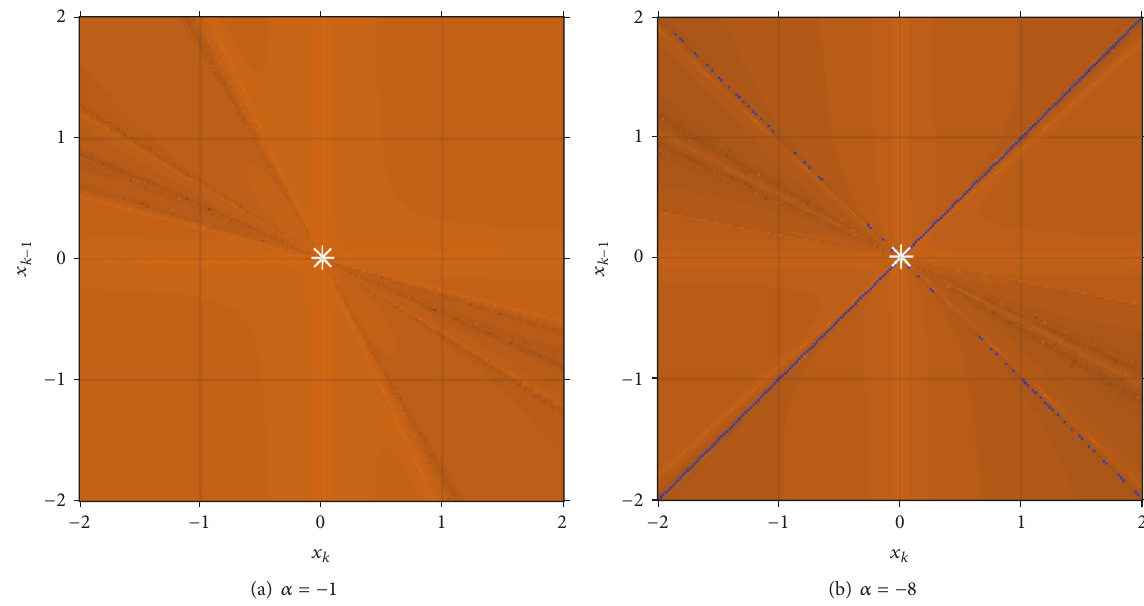
Figure 12: Dynamical planes of method 𝑀 𝛼 (𝑧, 𝑥) for 𝑓(𝑥) = 𝑥 2 .